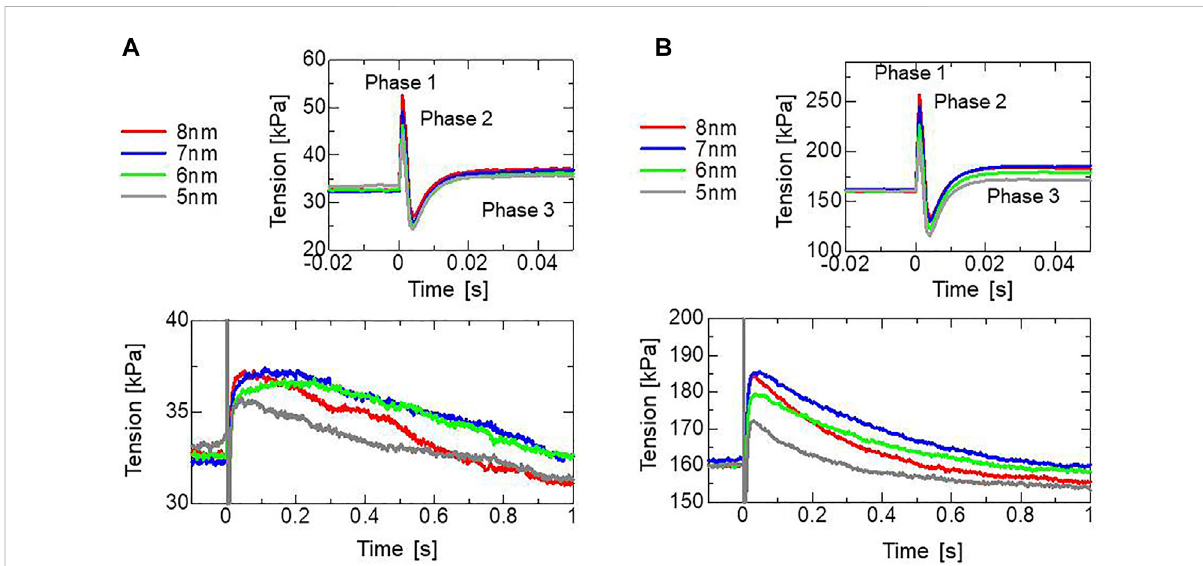
FIGURE 8 Numerical results of the stretch activation simulation. Stretches of 5, 6, 7, or 8 nm were applied over the time span of 1 ms at T (cid:2) 0 s after the isometric force had matured under constant [Ca 2+ ] = 0.3 μ m (A) and [Ca 2+ ] = 0.4 μ m (B) . Time courses of the tensions are color-coded by the stretching as follows: 5 nm (gray), 6 nm (light green),7 nm (blue), and 8 nm(red).Enlarged views of thetop, focusing on thetension decrease on the order of seconds are depicted on the